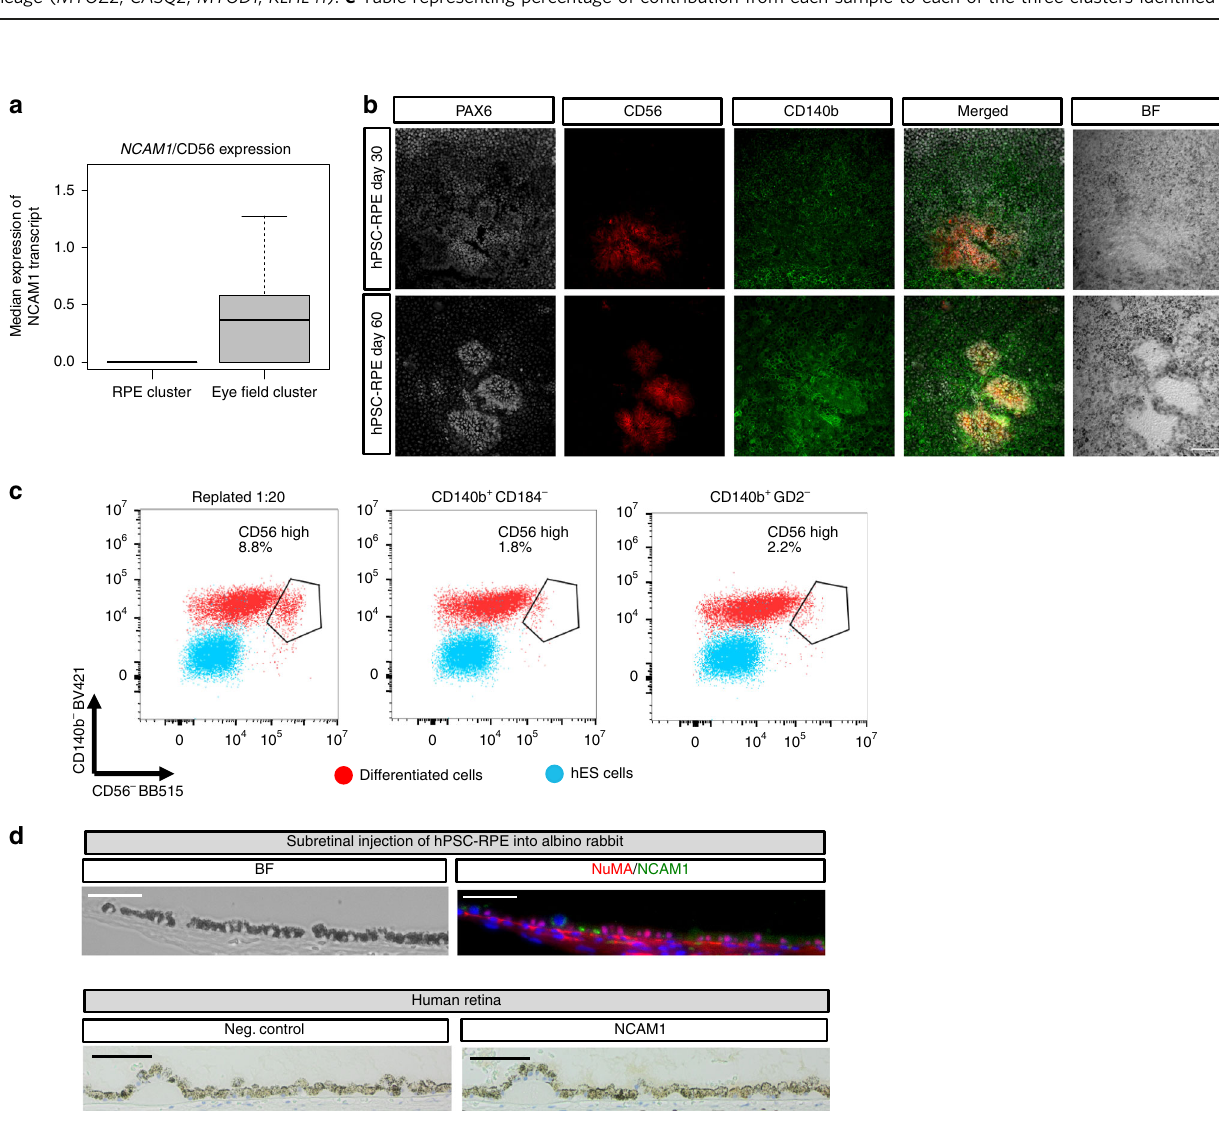
Fig. 4 Single-cell RNA-sequencing analysis following monolayer differentiation with and without cell surface marker enrichment. a Schematics representing the differentiation routines for the FACS-sorted and replated hPSC-RPE cells that will be analyzed by 10x Genomics scRNA-seq. Included in the schematics, representative density plots illustrating the FACS sorting strategy followed to separate CD140b + /CD184 − and CD140b + /GD2 − cells at day 30 of hPSC-RPE differentiation. These sorted populations were subsequently seeded and cultured on hrLN-521 until day 60 of differentiation, when they were analyzed by 10x Genomics scRNA-seq. b Violin plots representing module expression scores for distinctive genes of hPSC ( POU5F1 , NANOG , LIN28A , and SALL4 ) and RPE cells ( MITF , BEST-1 , RLBP1 , PMEL , TYR , RPE65 ). c tSNE representation of all cells showing cell lineage assignment of cells, using the 797 most variable genes across all cells. Cells are colored according to cluster and inferred cell type. d Feature plots displaying expression module scores over the tSNE plot for distinctive genes of RPE cells ( MITF , BEST-1 , RLBP1 , PMEL , TYR , RPE65 ), eye- fi eld ( SIX6 , VSX2 , PAX6 , OTX2 , SIX3 , LHX2 , RAX , ZIC1 ), and myogenic lineage ( MYOZ2 , CASQ2 , MYOD1 , KLHL41 ). e Table representing percentage of contribution from each sample to each of the three clusters identi fi ed in c .